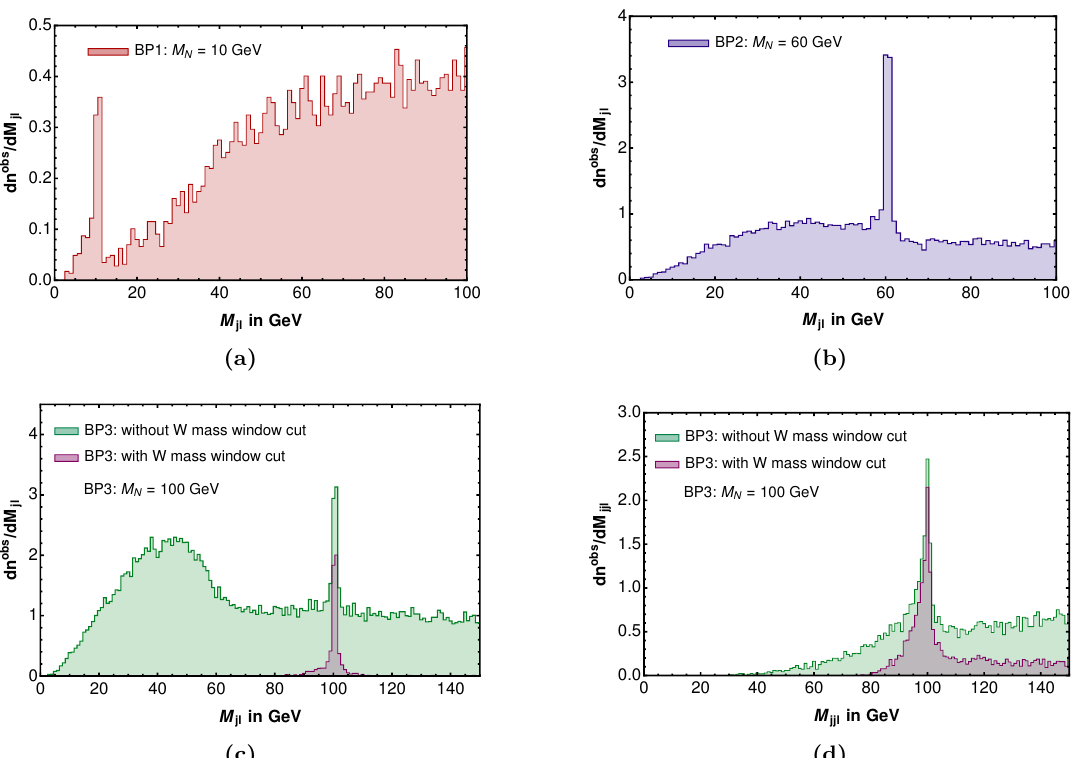
Figure 6. Reconstruction of RHN mass from heavily boosted Fatjet and mono-lepton ( M jl ) for BP1, BP2, BP3 (a, b, c) and mono-lepton-di-jet invariant mass for BP3 (d) at the LHC with the centre of mass energy of 14 TeV and the integrated luminosity of 3 ab − 1 . The purple colour represents the distribution after applying a window cut of 10 GeV around W ± mass, while the green represents the distribution of M and M for BP3 in (c) and (d), jl jjl